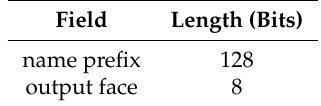
Table 2. Data structure of hash